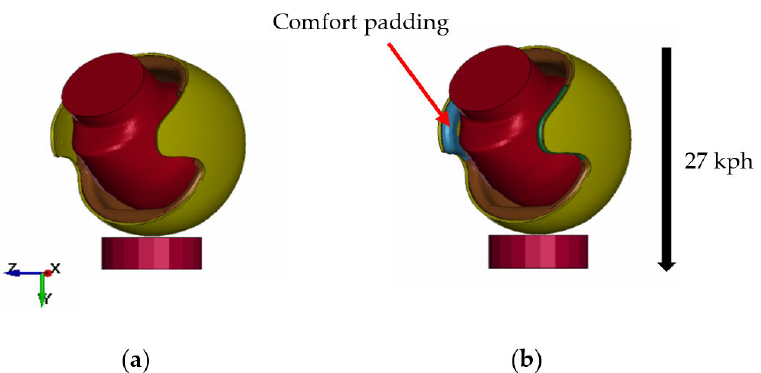
Figure 5. Model configurations for impact simulation according to TIS 369-2557. ( a ) Without comfort padding; ( b ) with comfort padding.